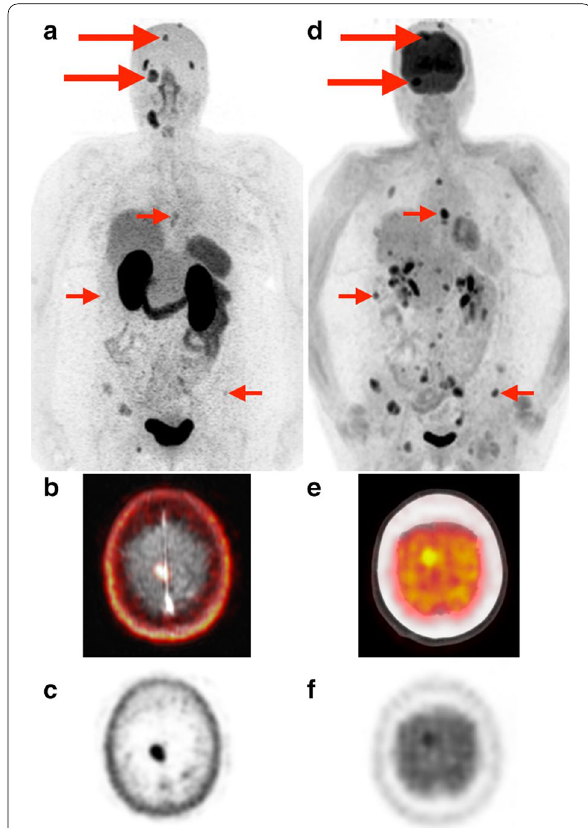
Fig. 5 Dural and skull base metastases.[ 68 Ga]Ga‑PSMA‑11 PET MIP ( a ) and 2‑[ 18 F]FDG PET MIP ( d ) in a patient (Patient 2) with Hurthle cell carcinoma. Dural and skull base metastases (large arrows) are better delineated on PSMA PET due to lack of background brain uptake (example: right falcine dural metastasis better seen on fused axial PSMA PET/MRI ( b ) and axial PSMA PET ( c ) than on fused axial FDG PET/CT ( e ) and axial FDG PET ( f ). Extensive metastatic disease involving the left adrenal gland, ribs, thoracolumbar spine, and pelvis is better seen on FDG PET in this